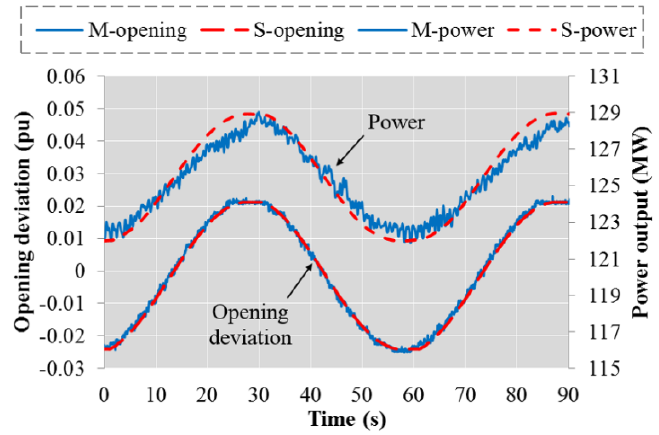
Figure 6. Power output and opening from simulation and measurement under sinusoidal frequency input (Case